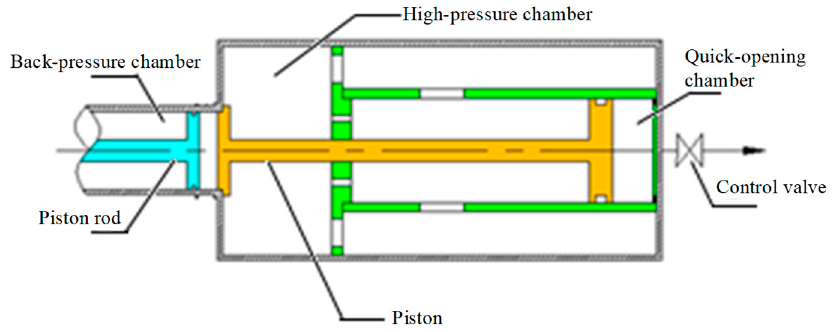
Figure 2. Schematic diagram of air cannon structure.